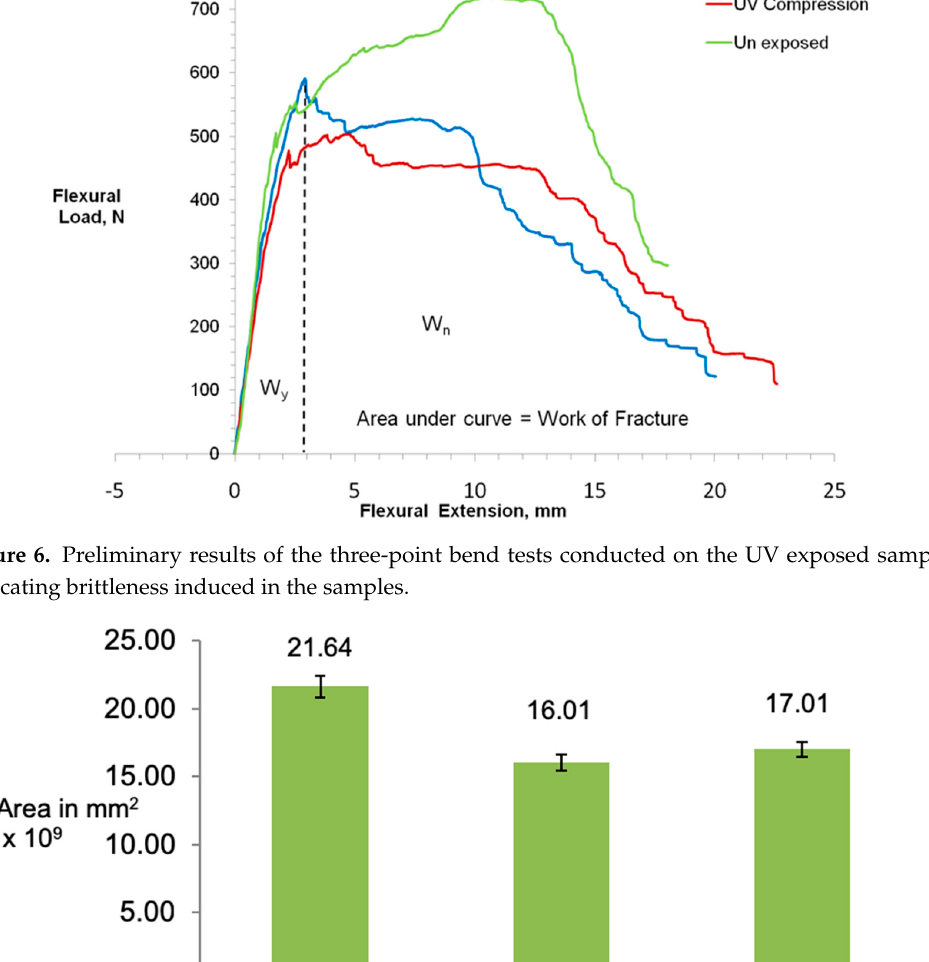
Figure 6. Preliminary results of the three-point bend tests conducted on the UV exposed samples indicating brittleness induced in the samples.